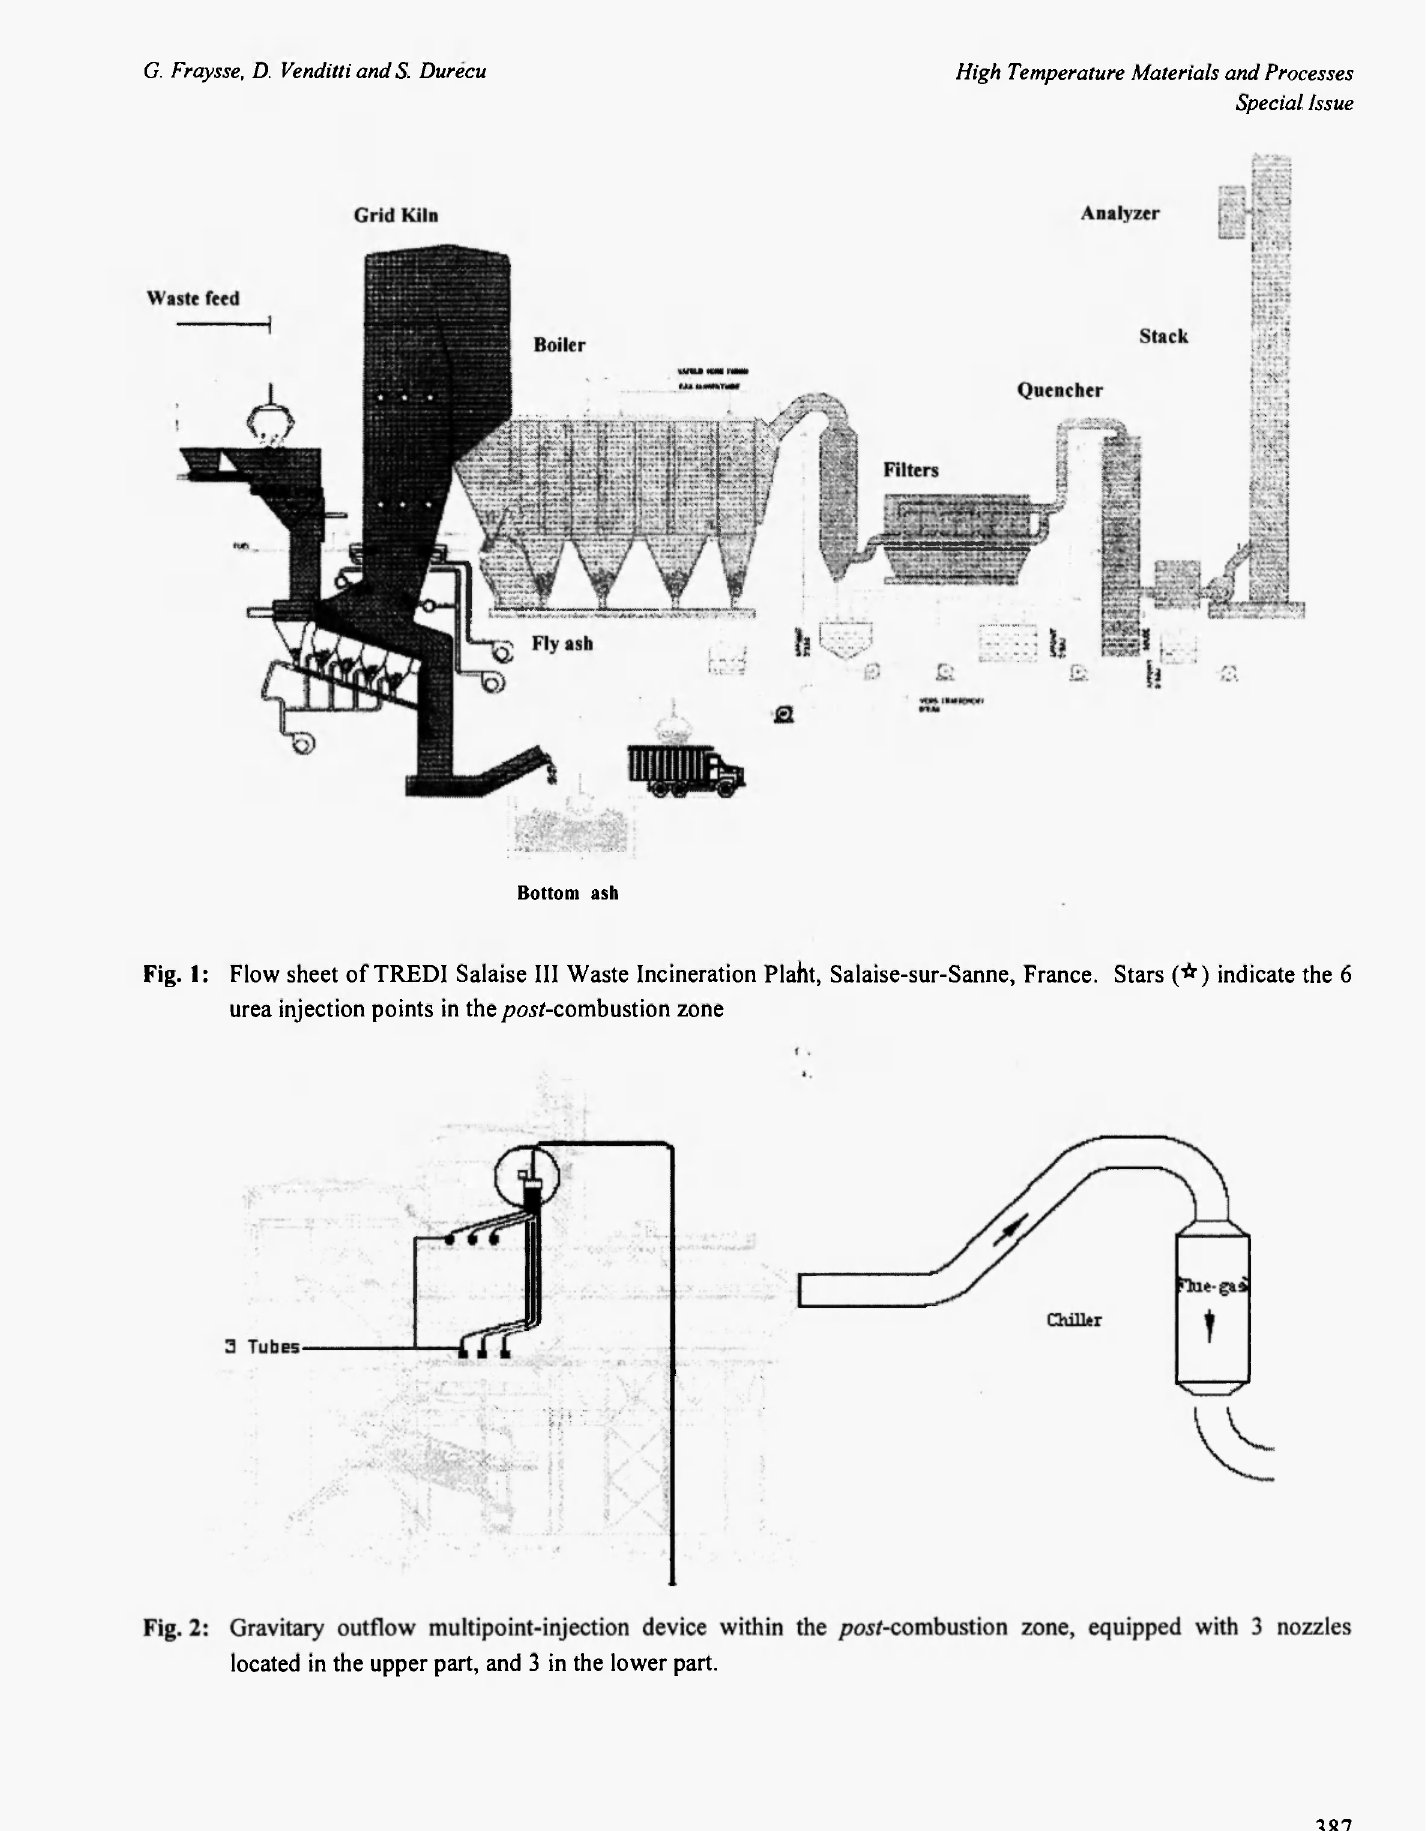
located in the upper part, and 3 in the lower